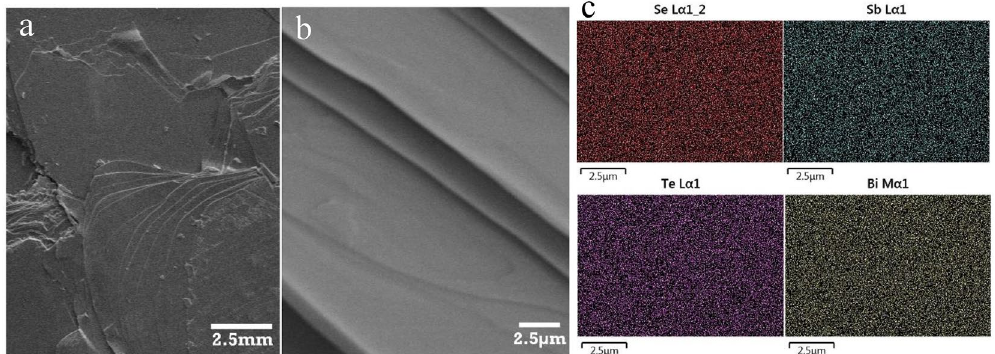
Figure 6. BSTS SEM and EDS. ( a ) BSTS low magnification SEM. ( b ) BSTS high magnification showing the crystal layers. ( c ) BSTS EDS showing a homogenous elemental distribution.